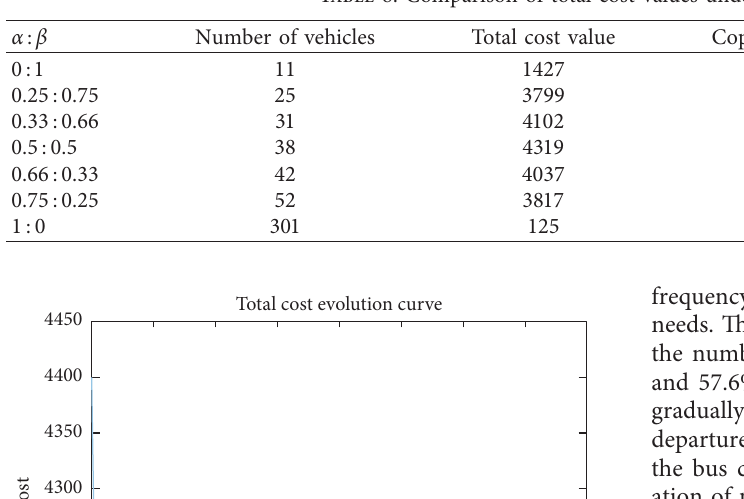
Table 8: Comparison of total cost values under different decisions.